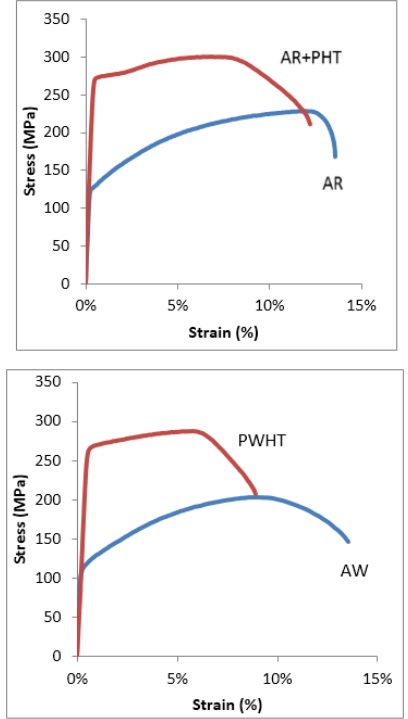
Figure 8. Stress versus Strain response of 9.5 mm (3/8 in) thick AA6063 in the as received (AR), as-received plus precipitation heat treated (AR+PHT), as-welded (AW) and post weld heat treated (PWHT) conditions.